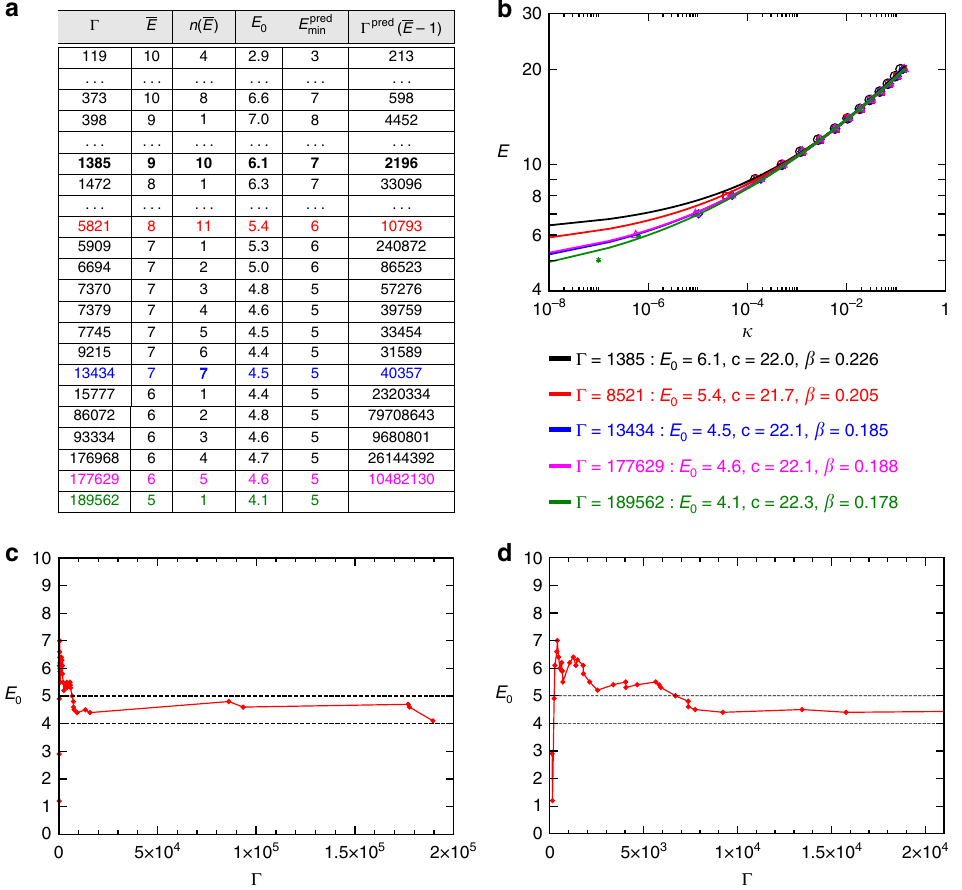
Fig. 4 Algorithm performance on a hard benchmark problem. We use the same problem as in Fig. 2. a Γ is the number of trajectories, E the lowest energy (cid:6) (cid:7) found until that point, n E is the number of times this energy has been found, E 0 is the parameter obtained from fi tting of Eq. (5), E pred (cid:6) (cid:7) Γ pred E (cid:2) 1 . The algorithm estimates the escape rate and performs a prediction at each Γ shown in the table and for the colored lines we show the fi tting curves in ( b ). c The relevant parameter E 0 is shown as function of Γ . While it wildly fl uctuates at the beginning when the statistics is small, it remains in the E ∈ [4, 5) interval, convincingly predicting E pred 5 already after Γ = 7000 up until the point that it fi nds this energy at Γ = 189,562. At this point it could 0 min ¼ be expected that we do not have a good estimate for κ (5) because it has been found only once ( n (5) = 1), nevertheless the estimation E pred consistently the same, convincing our algorithm to accept E dec ¼ 5 and stop. d A zoom into the [0, 2 × 10 4 ] interval of ( c ) min